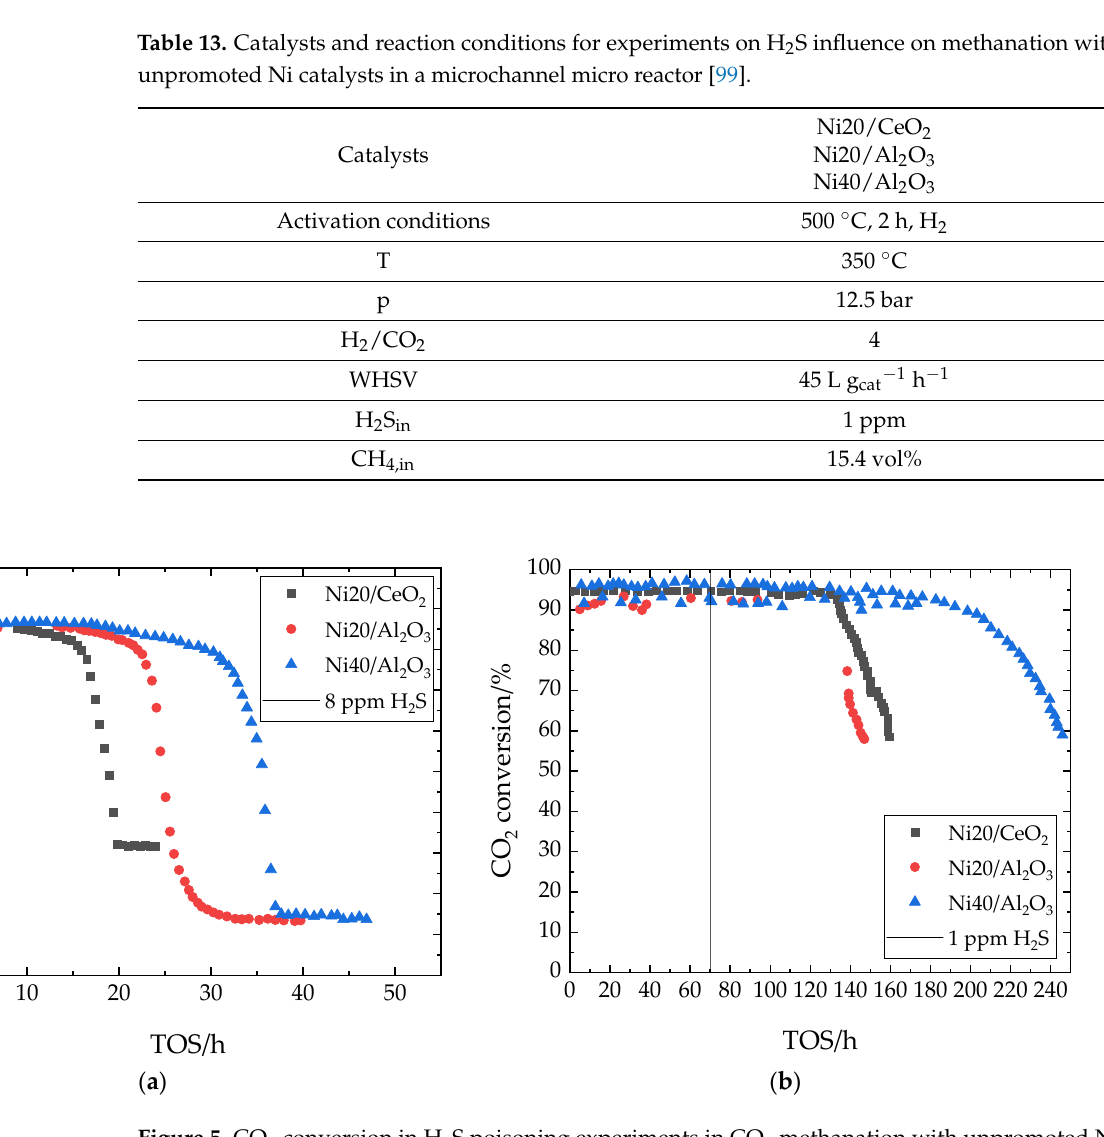
Figure 5. CO 2 conversion in H 2 S poisoning experiments in CO 2 methanation with unpromoted Ni catalysts in ( a ) fixed-bed reactor and ( b ) microchannel reactor with CH 4 in the inlet gas